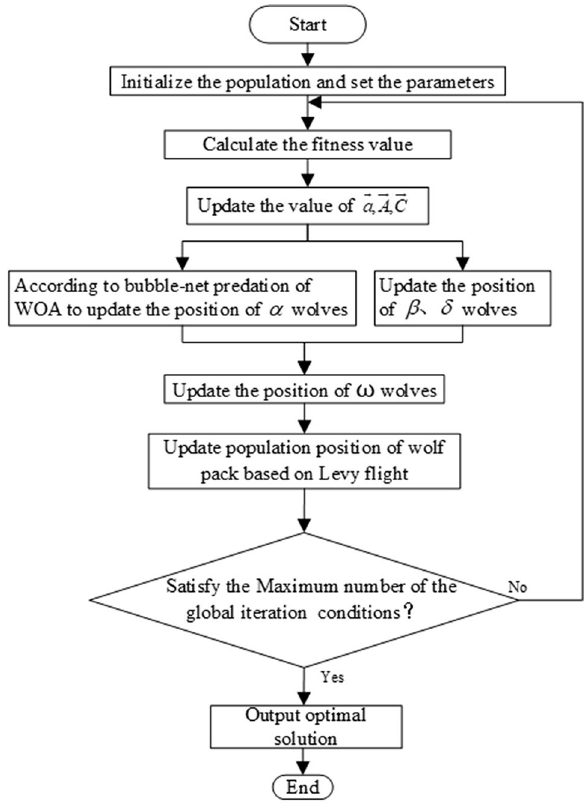
Figure 1. Flow chart of GWO_BP.